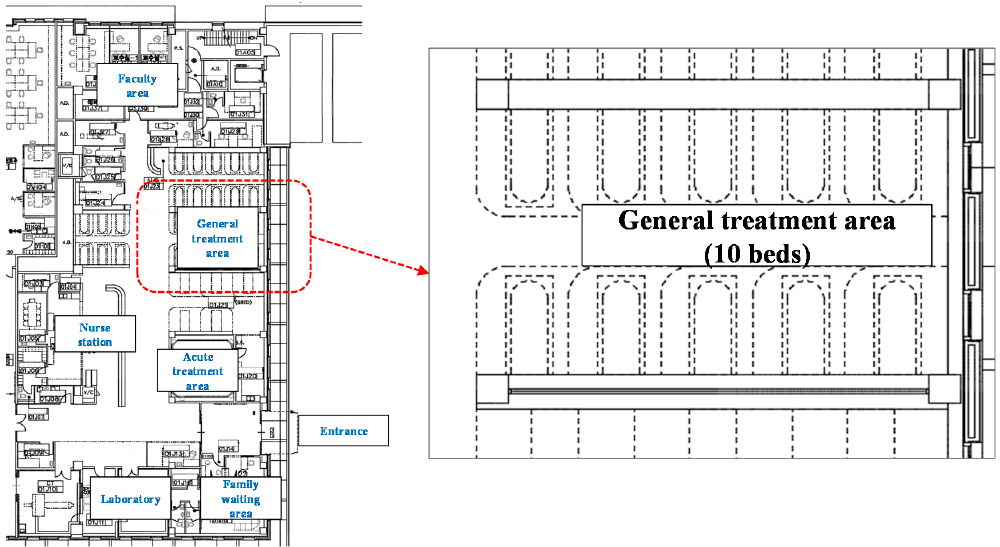
Figure 1. Target area in the ED (emergency department).